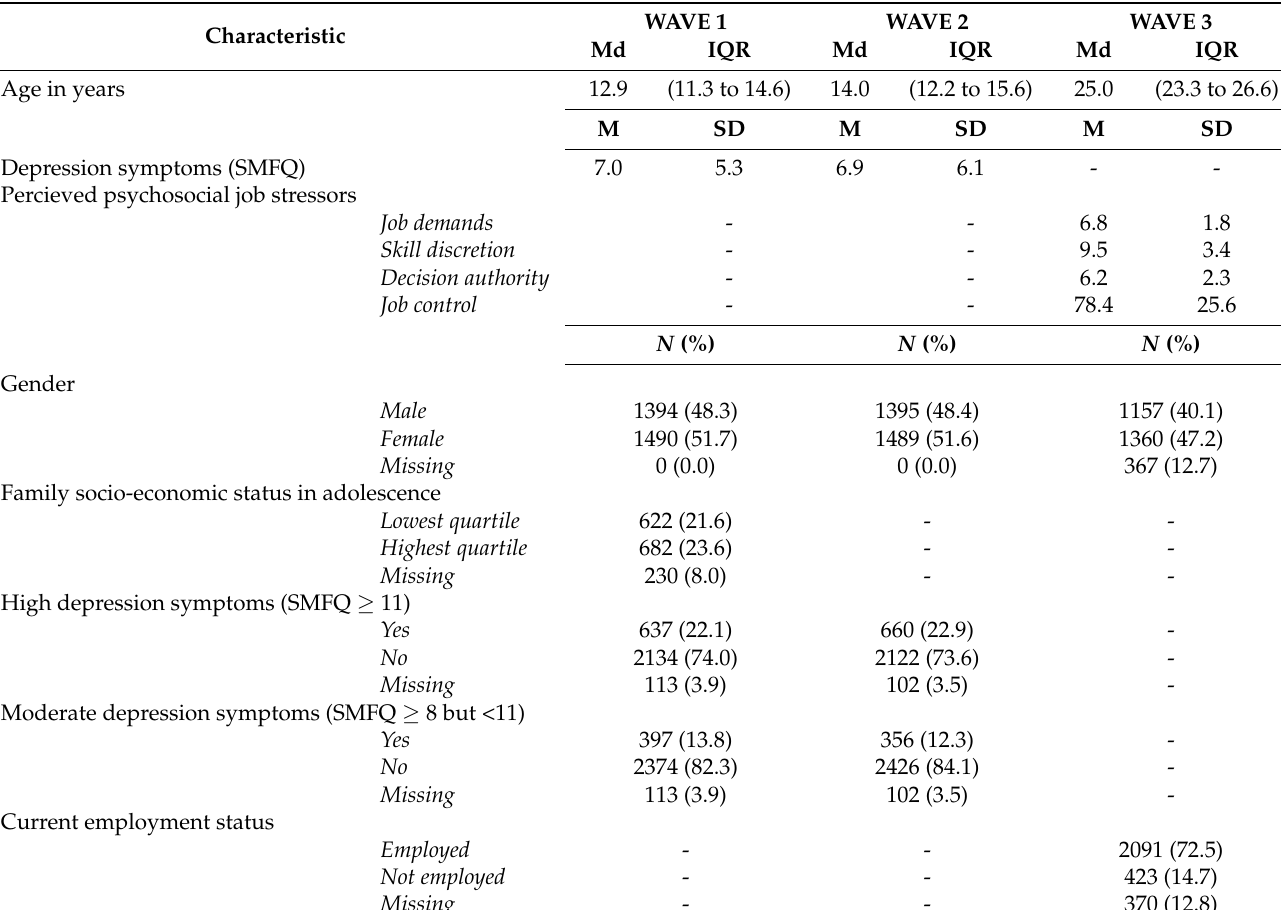
Table 1. Characteristics of the respondents at the adolescent (one and two) and young adulthood (three) waves of the International Youth Development Study (IYDS).